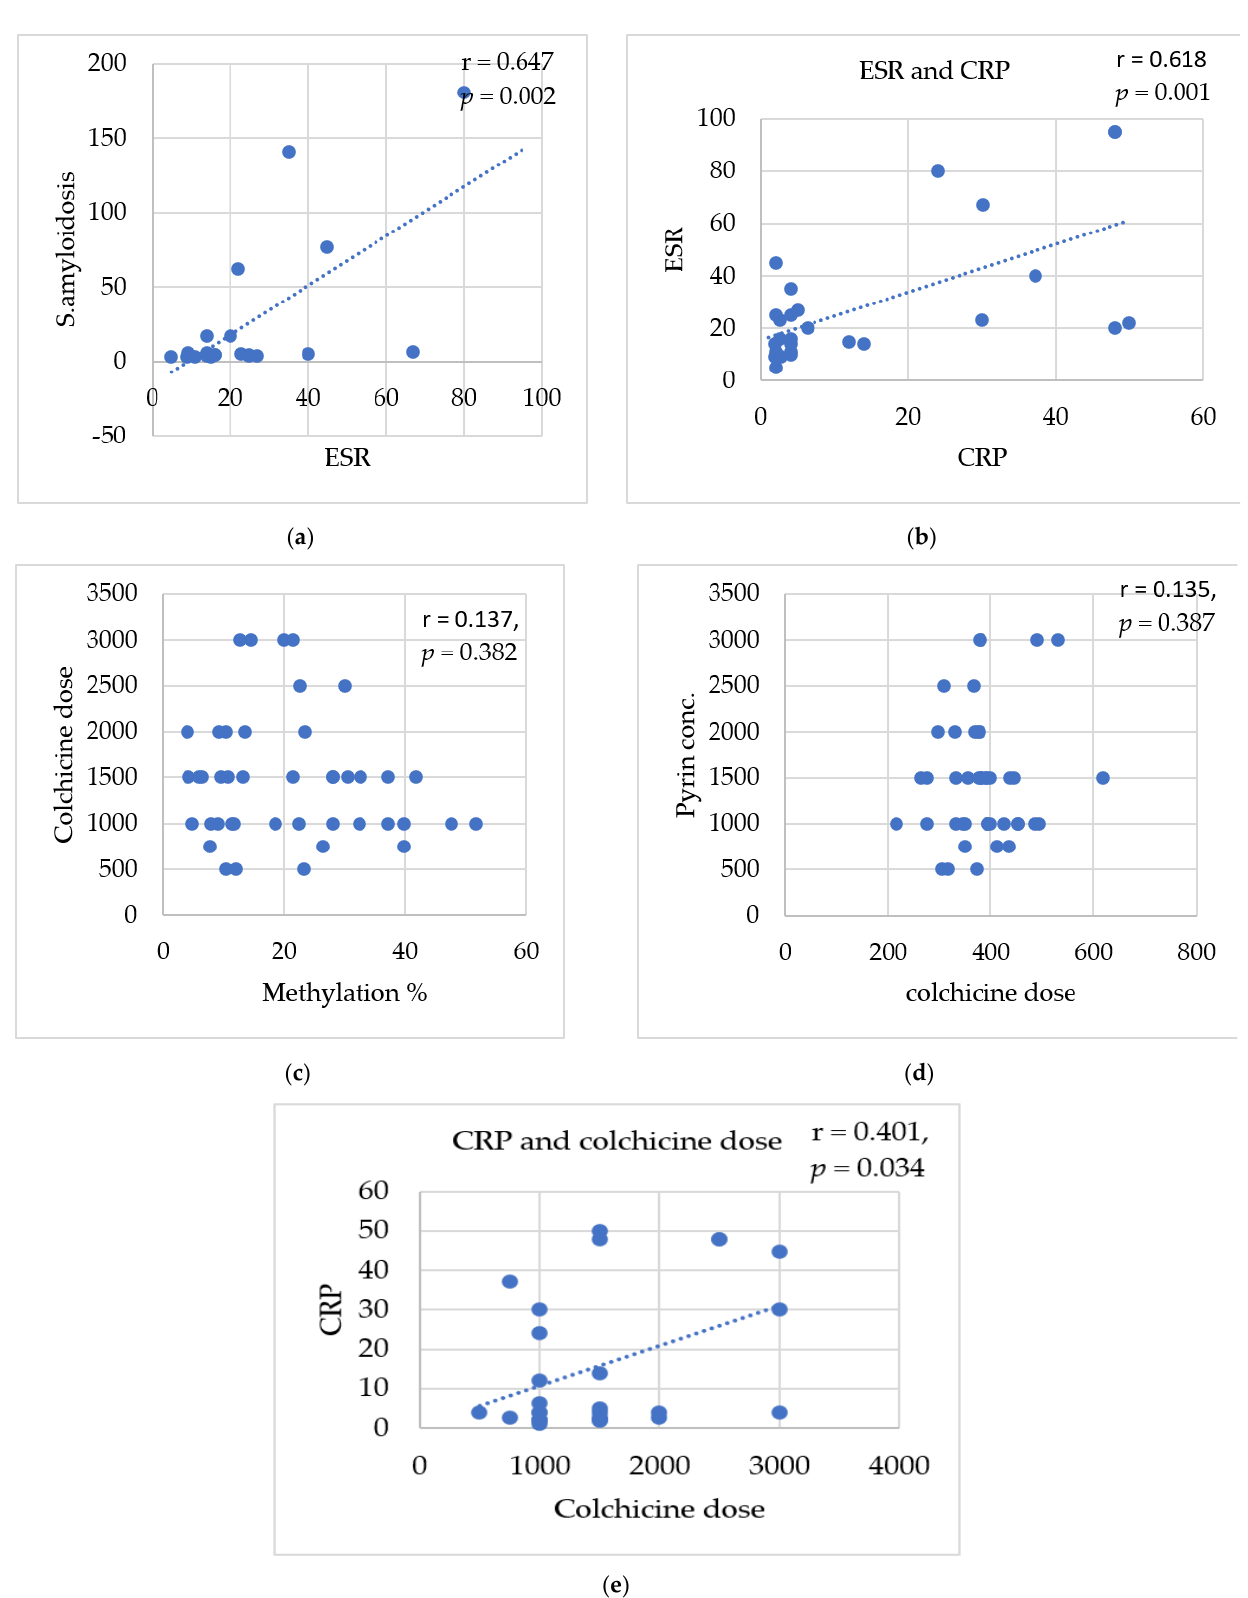
Figure 5. Correlation between biomarkers, colchicine dose, MEFV exon 2 methylation%, and pyrin level among FMF patients: ( a ) ESR and SAA; ( b ) ESR and CRP; ( c ) colchicine dose and MEFV exon 2 methylation%; ( d ) colchicine dose and pyrin level; ( e ) colchicine dose and CRP.